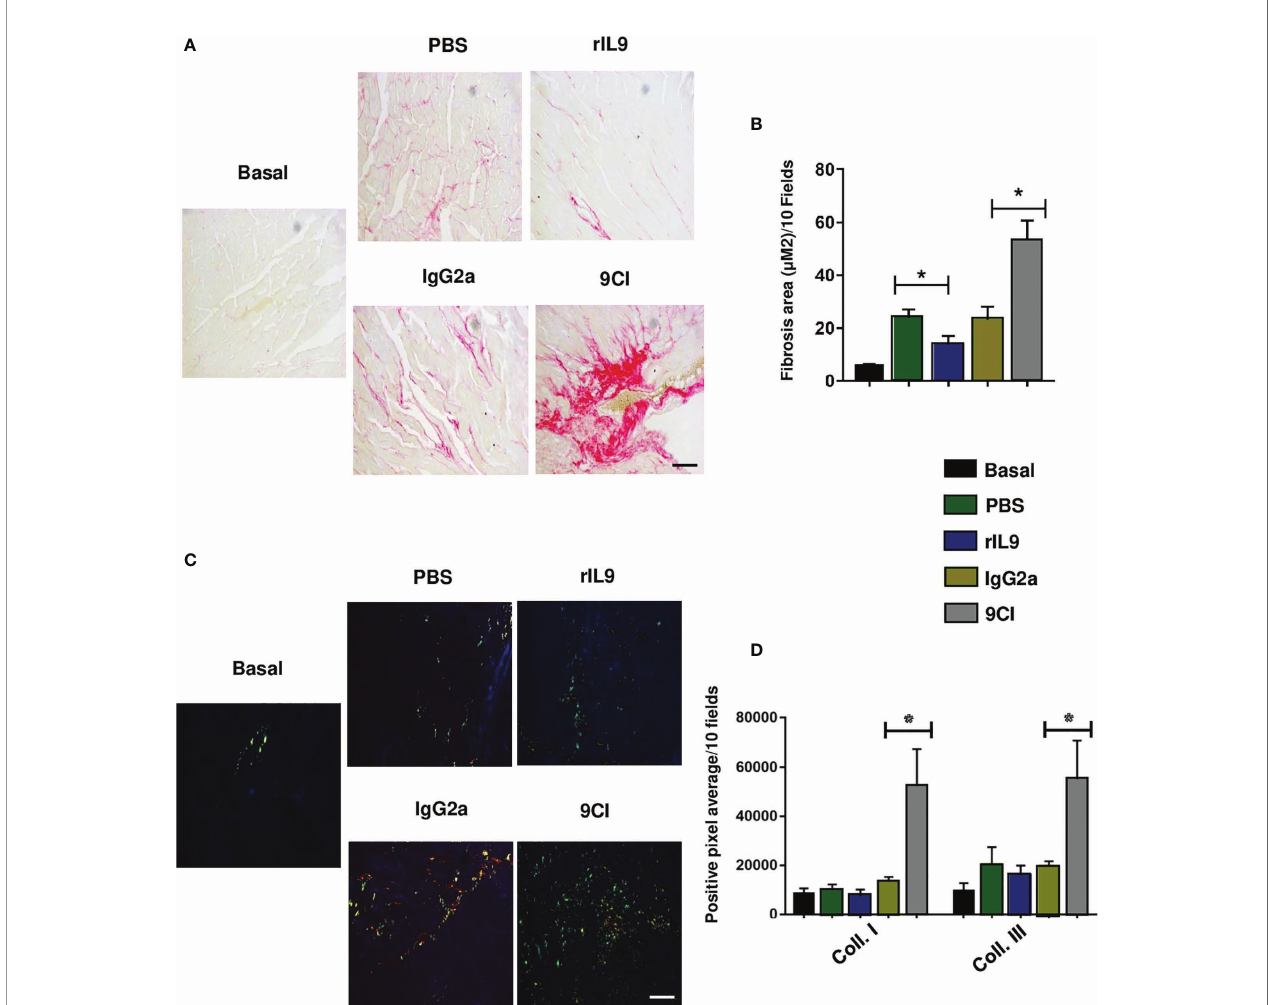
FIGURE 8 | IL-9 neutralization increased and rIL9 treatment reduced cardiac fi brosis in Trypanosoma cruzi -infected mice after 60 dpi. (A) Representative photomicrograph of cardiac fi brosis after 60 dpi in uninfected and untreated mice (basal), and those infected and treated with: PBS, rIL9 (50 ng/animal), 9CI (100 m g/ animal), or IgG2a (100 m g/animal). Black arrow shows the collagen network stained with picrosirius red. (B) Graph shows the quanti fi cation of total collagen fi bers ( fi brosis area) in 10 random fi elds. (C) Representative photomicrograph of type I collagen fi bers (red), type III collagen fi bers (green), and both fi ber types (yellowish/ orange) in cardiac tissue from uninfected and untreated (basal), infected and treated with PBS, infected and treated with rIL9 (50 ng/animal), infected and treated with 9CI (100 m g/animal), or infected and treated with IgG2a (100 m g/animal) mice after 60 dpi. (D) Graph shows the quanti fi cation of type I and III collagen fi ber in 10 random fi elds (microscope objective 40×). Anova test *p < 0.001. Control: uninfected and untreated mice. Bar: 500 m